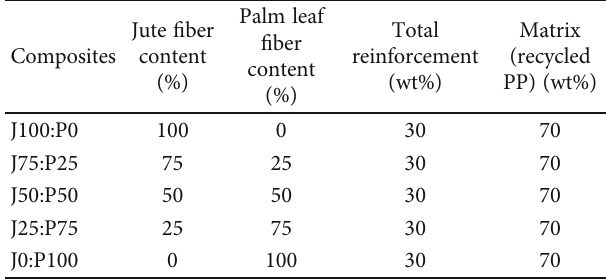
Figure 2: DSC analysis of PP, jute, and palm leaf fi bers. Table 2: Jute/palm leaf fi ber-reinforced polymer